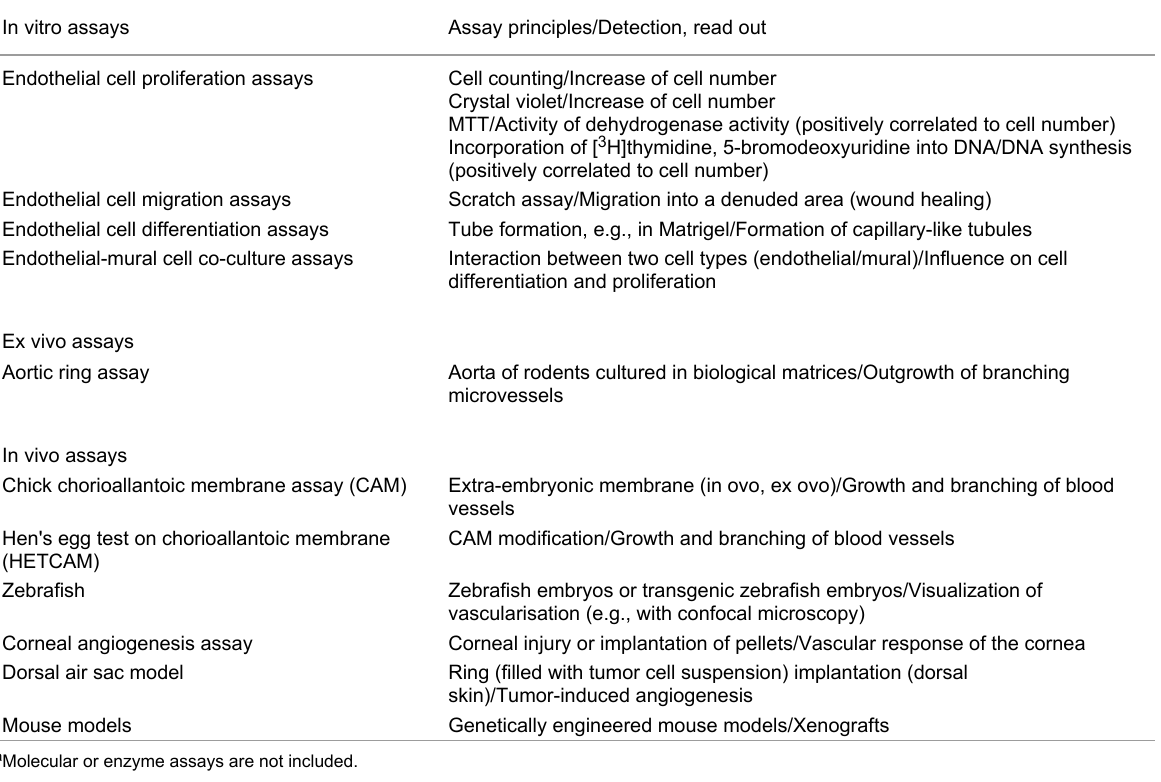
Table 2: In vitro, ex vivo and in vivo assays used to evaluate anti-angiogenic activity. a